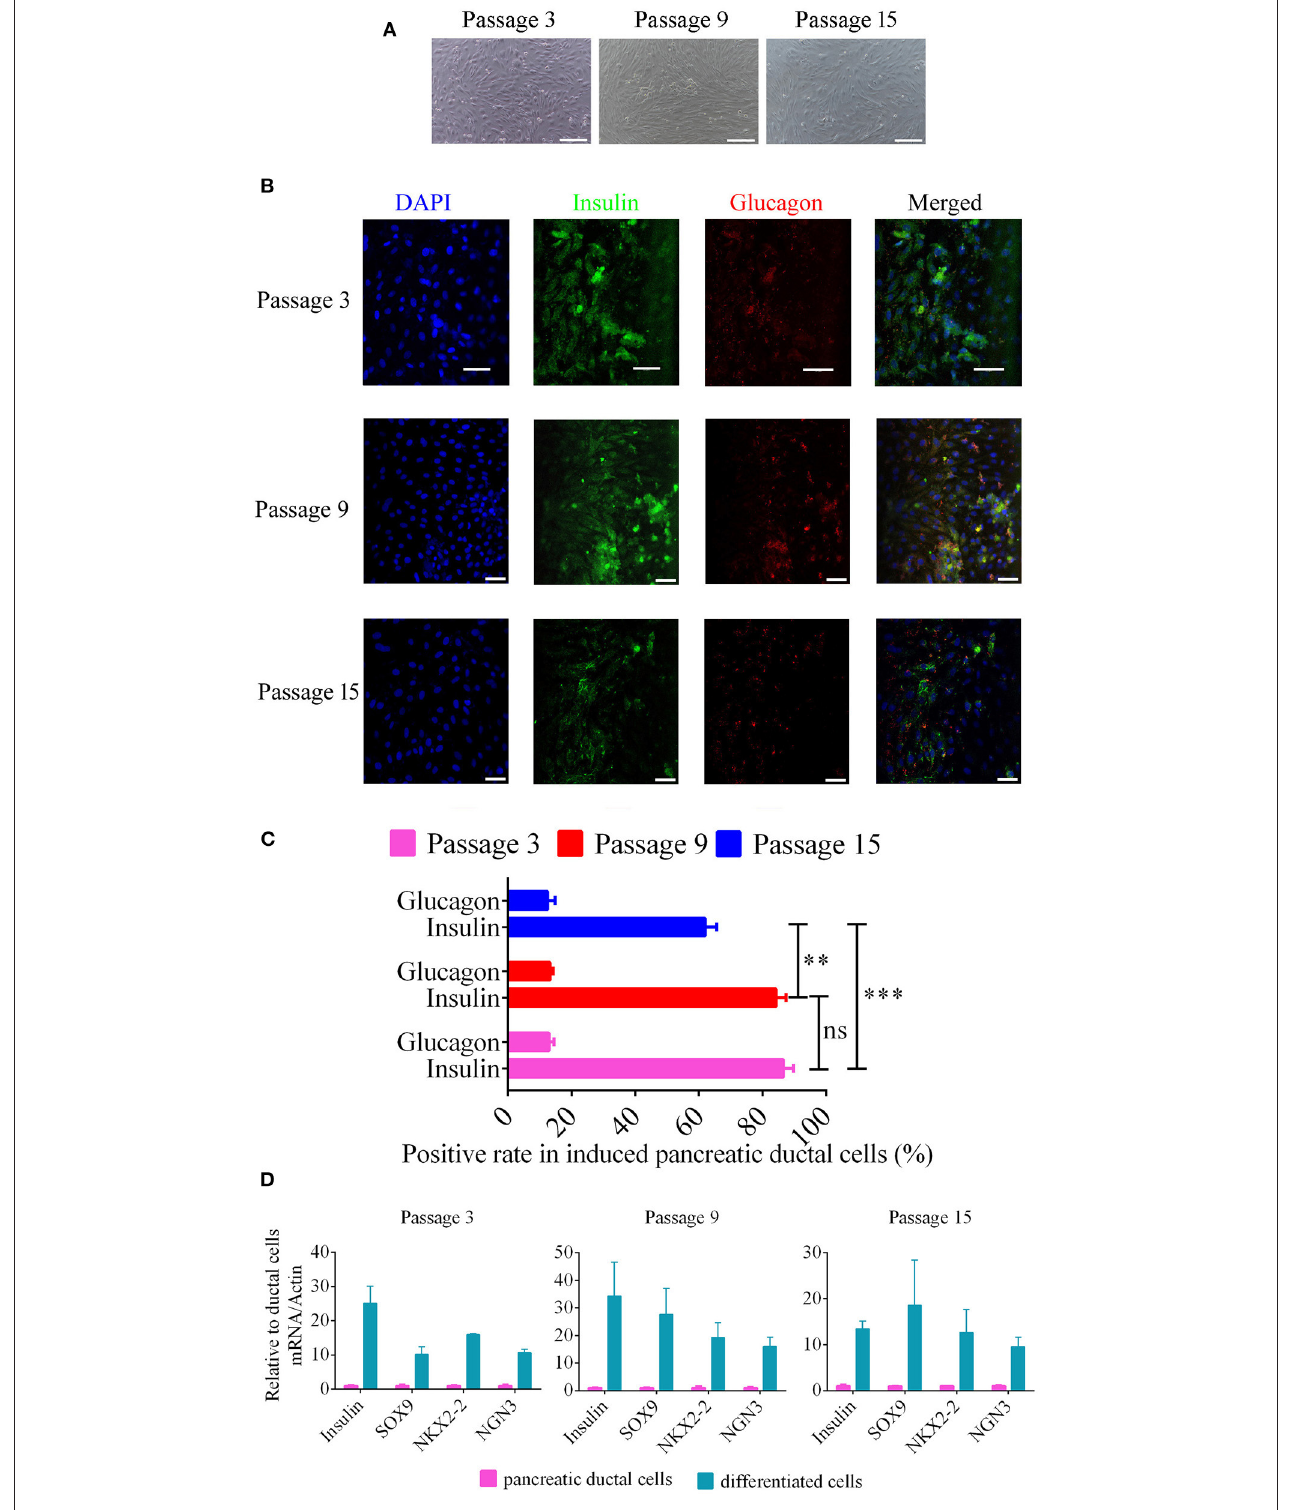
FIGURE 4 | Beta-like pancreatic islet cell differentiation from pancreatic ductal cells. (A) Morphology of differentiated ductal cells, cell clusters were appeared after 14 days of continuous treatment. Scale bar = 100 µ m. (B) The expression of insulin and glucagon were detected using immunofluorescence in induced pancreatic ductal cells derived from different passages. Scale bar = 50 µ m. (C) Analysis of the rate of insulin and glucagon positivity in induced pancreatic ductal cells derived from different passages ( n = 10). (D) Gene expression of differentiated cells from ductal cells at passage 3, 9, and 15 compared with normal cells. ** P < 0.01, *** P < 0.001.